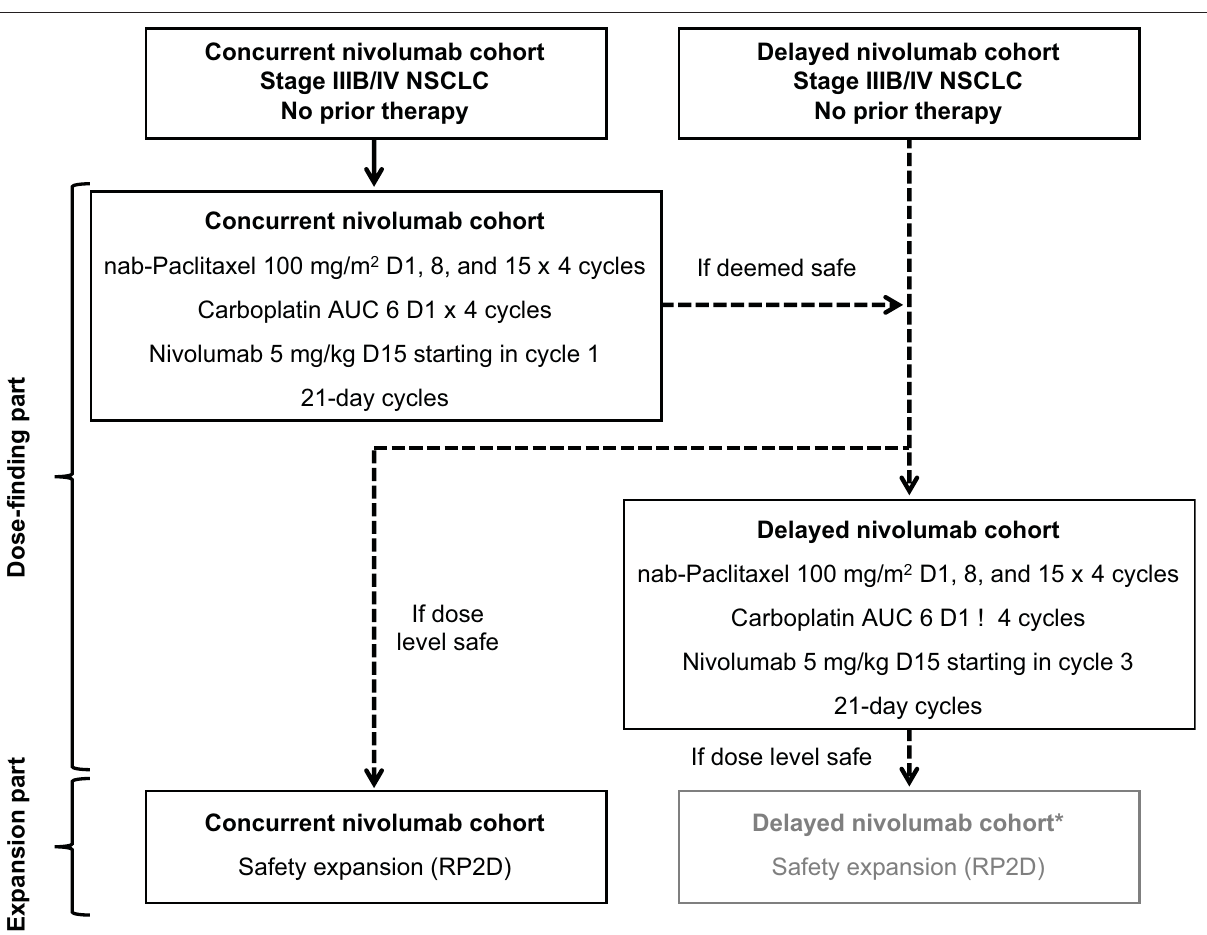
4 patients discontinued treatment due to progressive